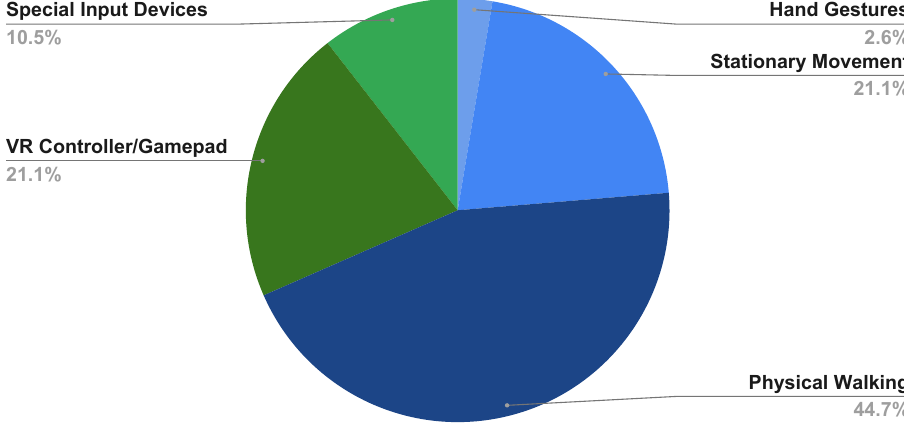
Figure 1. Locomotion techniques used in research papers in the years